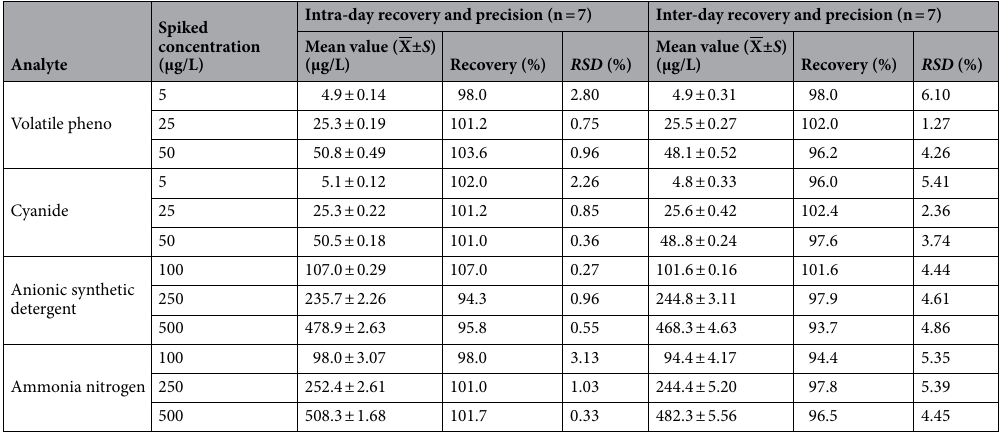
Table 3. The recoveries and relative standard deviations (RSD) at three spiked levels of 4 analytes.